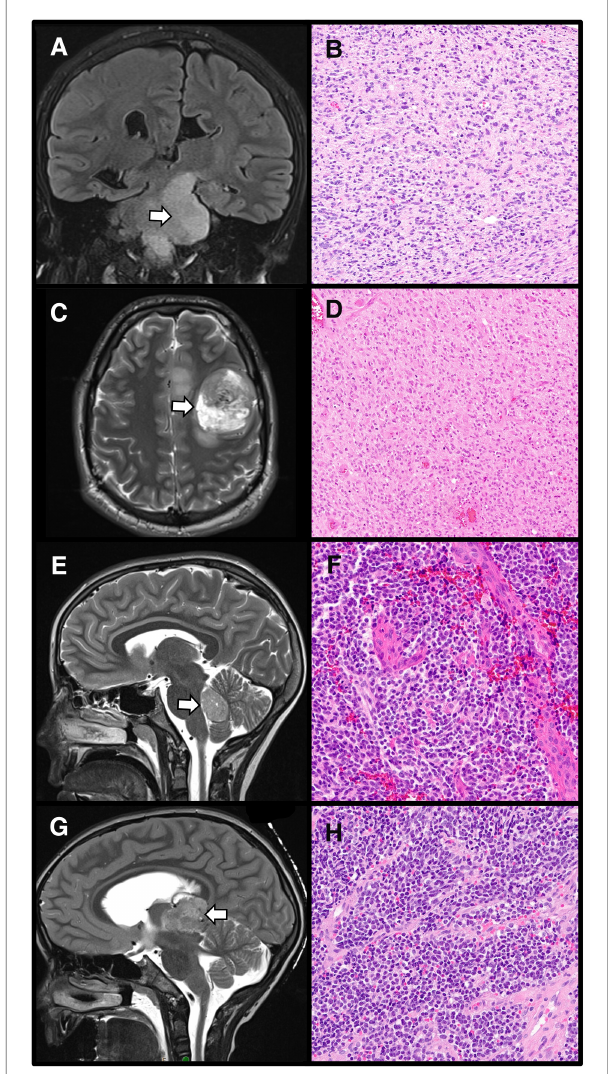
FIGURE 3 The importance of radiographic localization for central nervous system tumors. A diffuse midline glioma, H3 K27-altered, appearing as an ill- de fi ned left brainstem T2 hyperintensity within the required midline location ( A : Coronal T2-weighted MRI, arrow designates tumor) with corresponding histology demonstrating an in fi ltrative, cellular tumor with nuclear atypia ( B : H&E stain, 100× magni fi cation). In contrast, diffuse hemispheric gliomas, H3 G34-mutant are located within the cerebral hemispheres ( C : Axial T2-weighted MRI, arrow designates tumor). These tumors show high-grade histology ( D : H&E stain, 100× magni fi cation). Medulloblastomas are embryonal tumors arising within the posterior fossa ( E : Sagittal T2-weighted MRI, arrow designates tumor) which demonstrate poorly differentiated cells, often with a high nuclear to cytoplasmic ratio, and high mitotic activity ( F : H&E stain, 200× magni fi cation). Location within the pineal region ( G : Sagittal T2-weighted MRI, arrow designates tumor) is required for a diagnosis of pineoblastoma, an embryonal tumor which histologically resembles other embryonal neoplasms arising outside the pineal parenchyma ( H : H&E stain, 200× magni fi